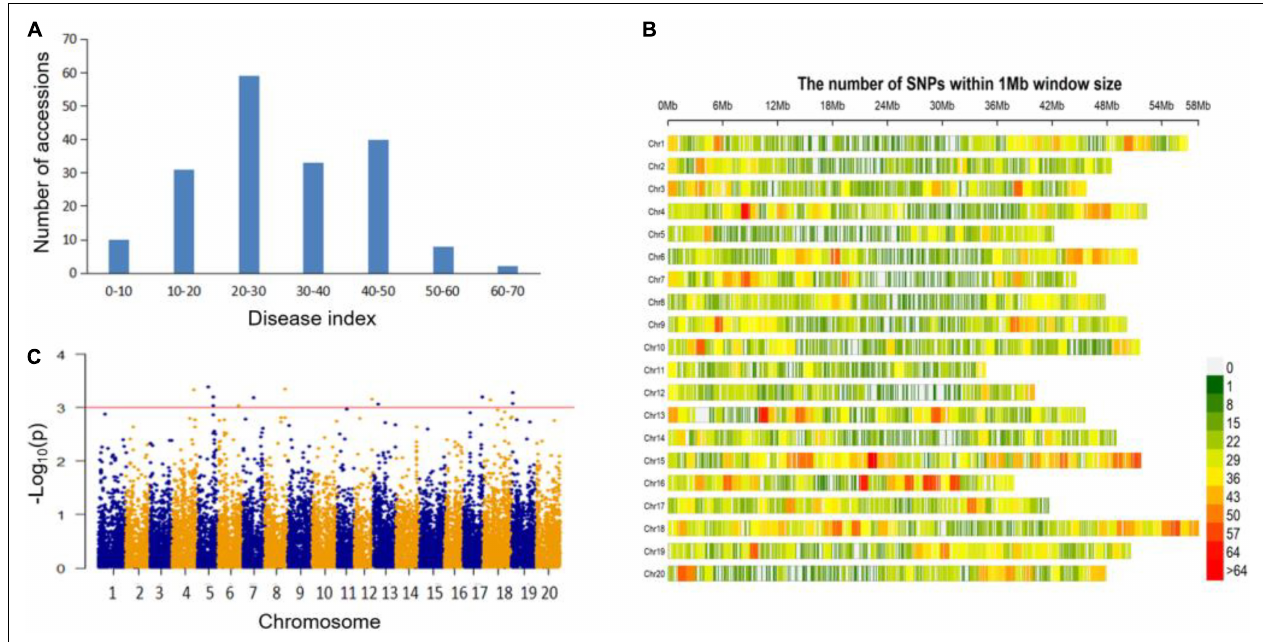
FIGURE 1 | Genome wide association study on soybean resistance to FLS race 1. (A) Distribution of FLS race 1 resistance among 183 soybean accessions. (B) SNP density and distribution across the 20 soybean chromosomes. (C) Manhattan plot of association mapping of FLS race 1 resistance.